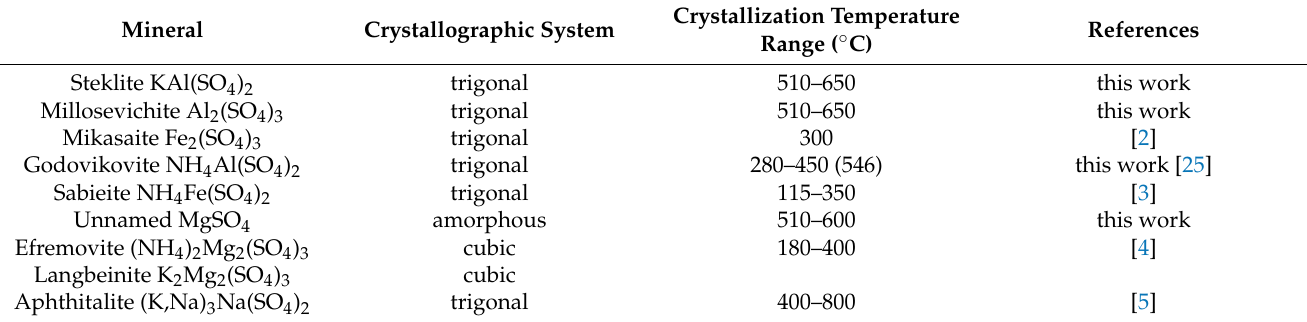
Table 2. Assemblages of high temperature sulfates from the Upper Silesian burning